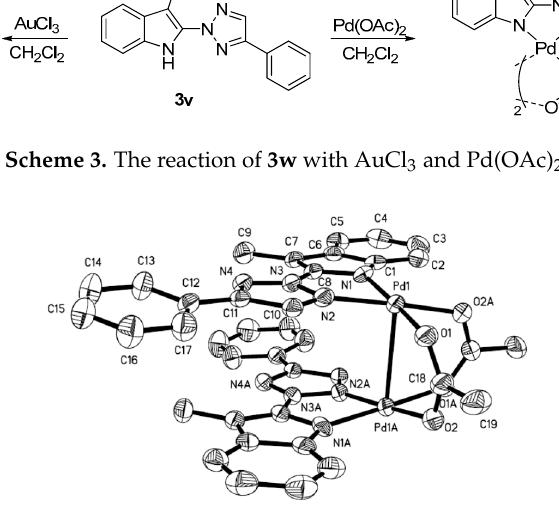
Figure 8. X-ray crystal structure of 5 .